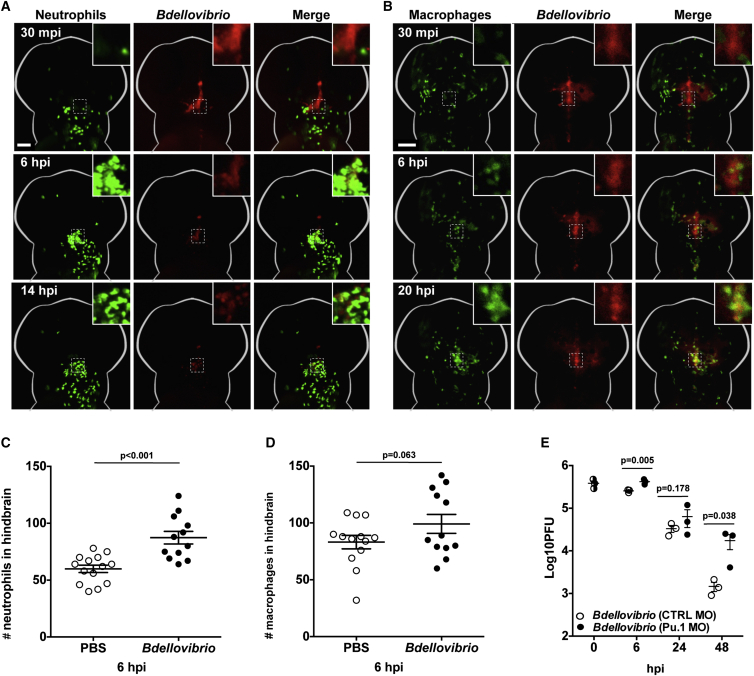
Bdellovibrio Is Recognized and Engulfed by Zebrafish Leukocytes In Vivo(A) 1–2 × 105 PFUs of mCherry-Bdellovibrio were injected into the hindbrain ventricle of Tg(mpx:GFP)i114 zebrafish larvae at 3 dpf, and interactions between neutrophils (green) and Bdellovibrio (red) were visualized by fluorescent stereomicroscopy. Representative images from a single larva over time are shown. Scale bar, 100 μm. See also Movie S3.(B) 1–2 × 105 PFUs of mTeal-Bdellovibrio were injected into the hindbrain ventricle of Tg(mpeg1:Gal4-FF)gl25/Tg(UAS-E1b:nfsB.mCherry)c264 zebrafish larvae at 3 dpf, and interactions between macrophages (green) and Bdellovibrio (red) were visualized by fluorescent stereomicroscopy. Representative images from a single larva over time are shown. Scale bar, 100 μm. See also Movie S3.(C) Tg(mpx:GFP)i114 zebrafish larvae were injected with PBS or Bdellovibrio as in (A), and GFP-expressing neutrophils present in the head region were quantified at 6 hpi. Each circle represents a count from an individual larva. Data are pooled from two independent experiments. The p value between conditions was determined by unpaired one-tailed Student’s t test. Significance was defined as p < 0.05.(D) Tg(mpeg1:Gal4-FF)gl25/Tg(UAS-E1b:nfsB.mCherry)c264 zebrafish larvae were injected with PBS or Bdellovibrio as in (B), and mCherry-expressing macrophages present in the head region were quantified at 6 hpi. Each circle represents a count from an individual larva. Data are pooled from two independent experiments. The p value between conditions was determined by unpaired one-tailed Student’s t test. Significance was defined as p < 0.05.(E) Tg(mpx:GFP)i114 zebrafish larvae were pre-treated using control (CTRL) or Pu.1-targeting morpholino (MO) to deplete leukocytes. Morphants were injected in the hindbrain ventricle at 3 dpf with either PBS or 3–5 × 105 PFU mCherry-Bdellovibrio. Live Bdellovibrio were enumerated from PBS homogenates of larvae. Each circle represents a count from an individual larva. Half-filled circles represent enumerations from larvae at time 0 and are representative of inocula for both conditions. Mean ± SEM (horizontal bars) is shown. The p value (between conditions at cognate time points) was determined by unpaired one-tailed Student’s t test. Significance was defined as p < 0.05. As inoculums from independent experiments were variable up to a log-fold, a representative of three independent experiments performed is shown. See also Figure S2E.See also Figure S2.